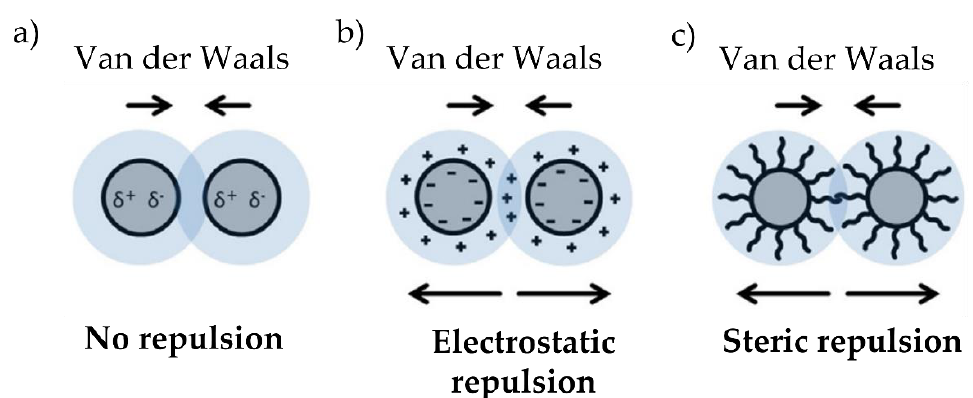
Figure 7. Zeta potential values of CA-IONPs, PVA-IONPs and SDS-IONPs under various molar ratios and salinities.